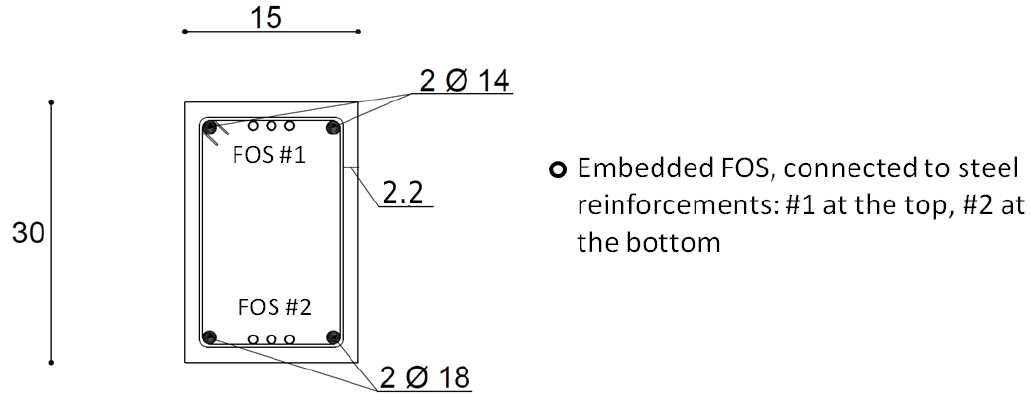
Figure 3. Fiber optic sensor (FOS) installation (dimensions in cm).